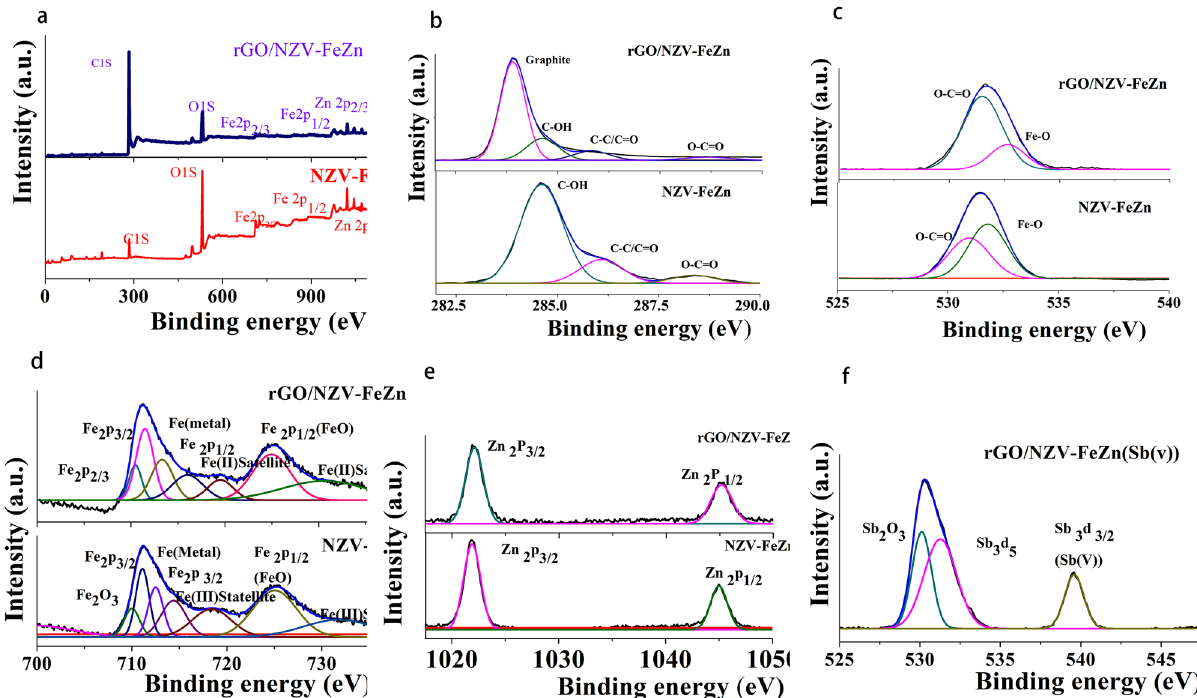
Figure 9. ( a ) X-ray photoelectron survey spectra of NZV-FeZn and rGO/NZV-FeZn, high-resolution ( b ) C 1s, ( c ) O 1s, ( d ) Fe 2p, and ( e ) Zn 2p spectra of NZV-FeZn and rGO/NZV-FeZn; f, high-resolution O 1s spectra of rGO/NZV-FeZn after Sb(V) via the photocatalytic